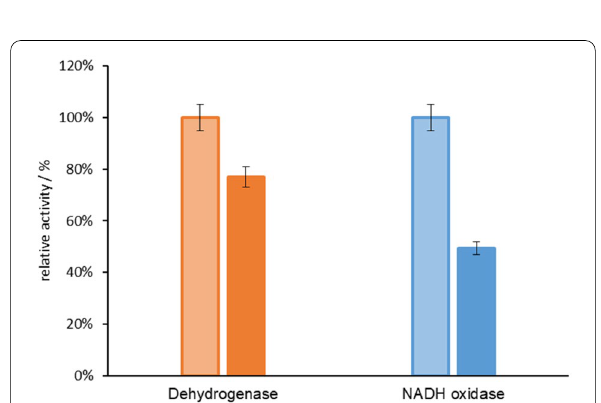
Fig. 4 Thermal stability diagram of GldA (orange bar) and SpNox K184R (blue bar)